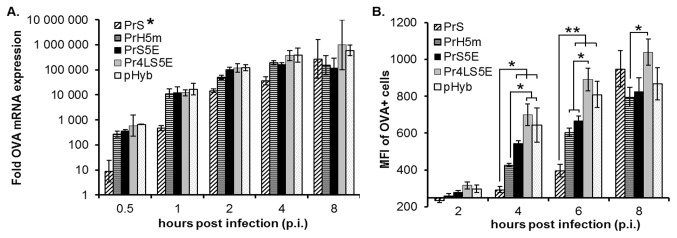
Expression kinetics of novel synthetic hybrid promoters.The kinetics and strength of the indicated promoters driving the expression of ovalbumin (OVA) were analysed in HeLa cells at the mRNA level (A) and at the protein level (B). (A) Samples were collected at 0.5, 1, 2, 4 and 8 hours post infection (p.i.). Total RNA was reverse transcribed and OVA cDNA was detected by qPCR. Fold OVA expression levels were calculated relative to wild-type MVA infected samples after normalization to actin levels using the delta-delta CT method. The average of three independent qPCR runs done in duplicates is shown. Error bars represent ± standard error of the mean (SEM) values. *, indicates the promoter was significantly different (p < 0.007) when compared to all other constructs (B) Infected cells were harvested at 2, 4, 6 and 8 hours p.i., stained intra-cellularly for OVA protein and analysed by flow cytometry. Samples staining positive for OVA (OVA+) were gated based on empty vector (MVA-EGFP) infected samples and the median fluorescence intensity (MFI) of OVA+ cells was calculated. For each virus group, three wells were infected using independent virus dilutions. The average MFIs above the background obtained from empty vector infected samples (MFI = 250) are shown. Error bars represent ± SEM values. Statistical differences between the indicated groups are shown by asterisks. * indicates p < 0.05; ** indicates p < 0.007.